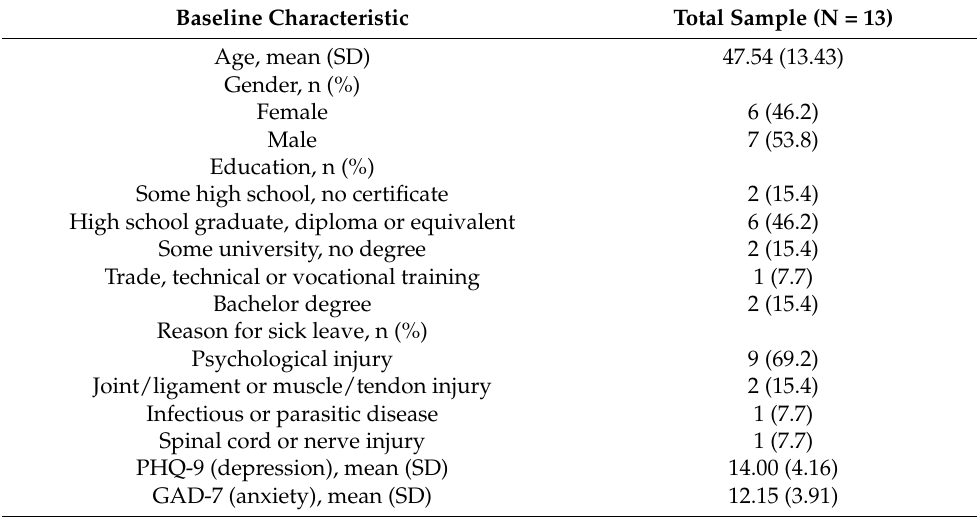
Table 3. Baseline participant